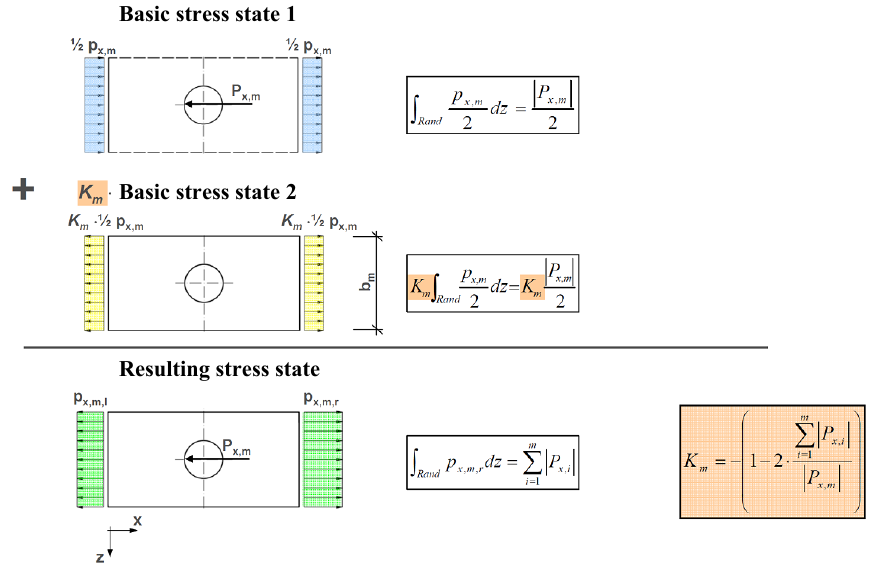
Figure 8: Derivation of the resulting stress state and determination of the parameter K m for joints loaded by normal load.